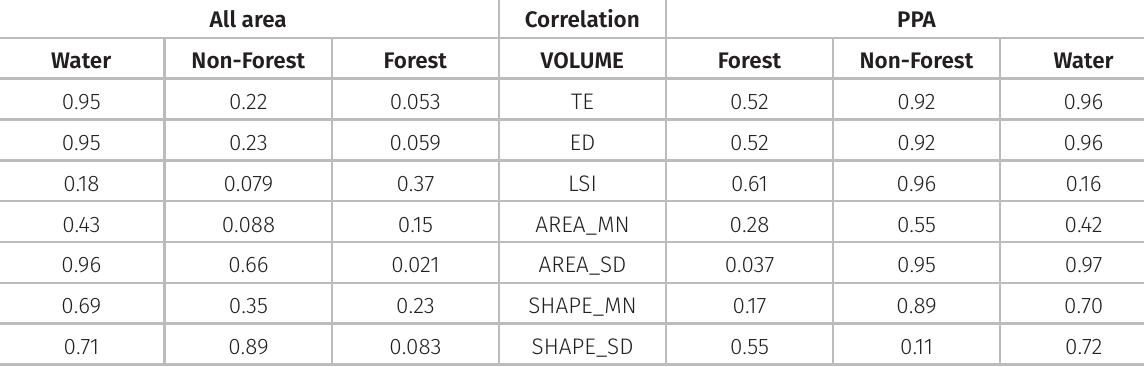
Table IV. Correlation between Serra Azul reservoir volume and form landscape metrics throughout the study region and in the permanent preservation